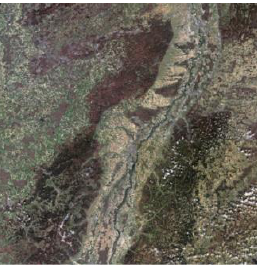
Figure 3 . RGB image of Sentinel-2 from the second study